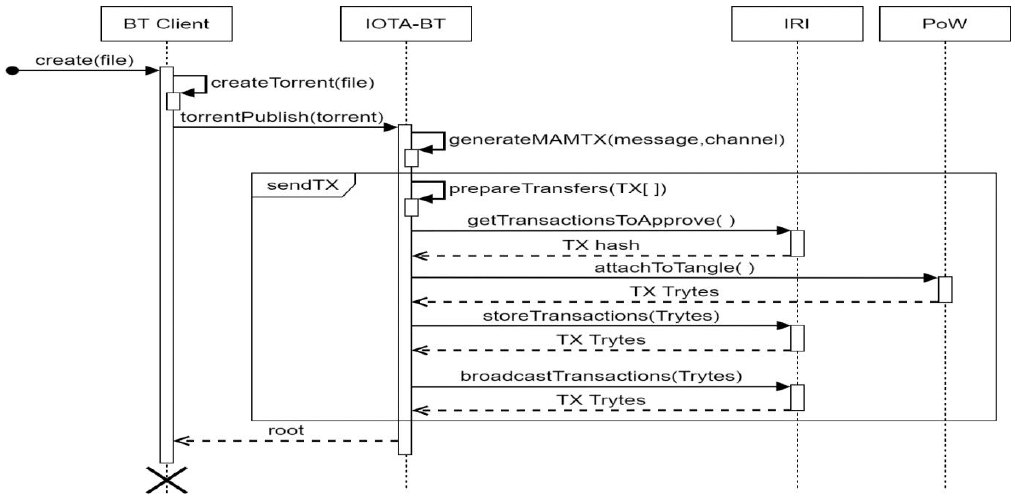
Figure 5. Publishing process in IOTA-BT.